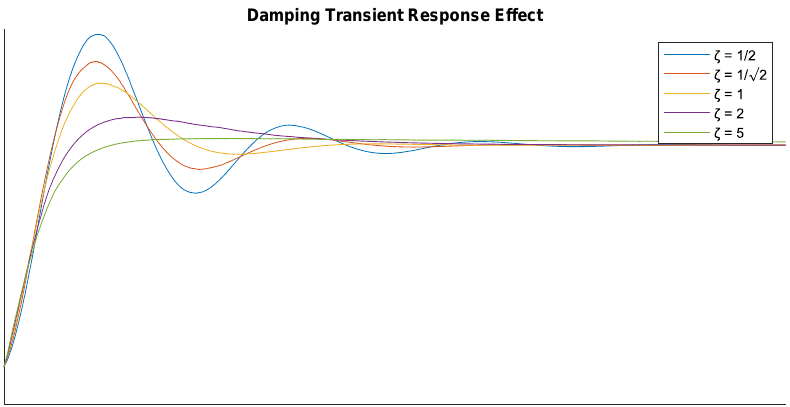
Figure 10. Damping effect on transient